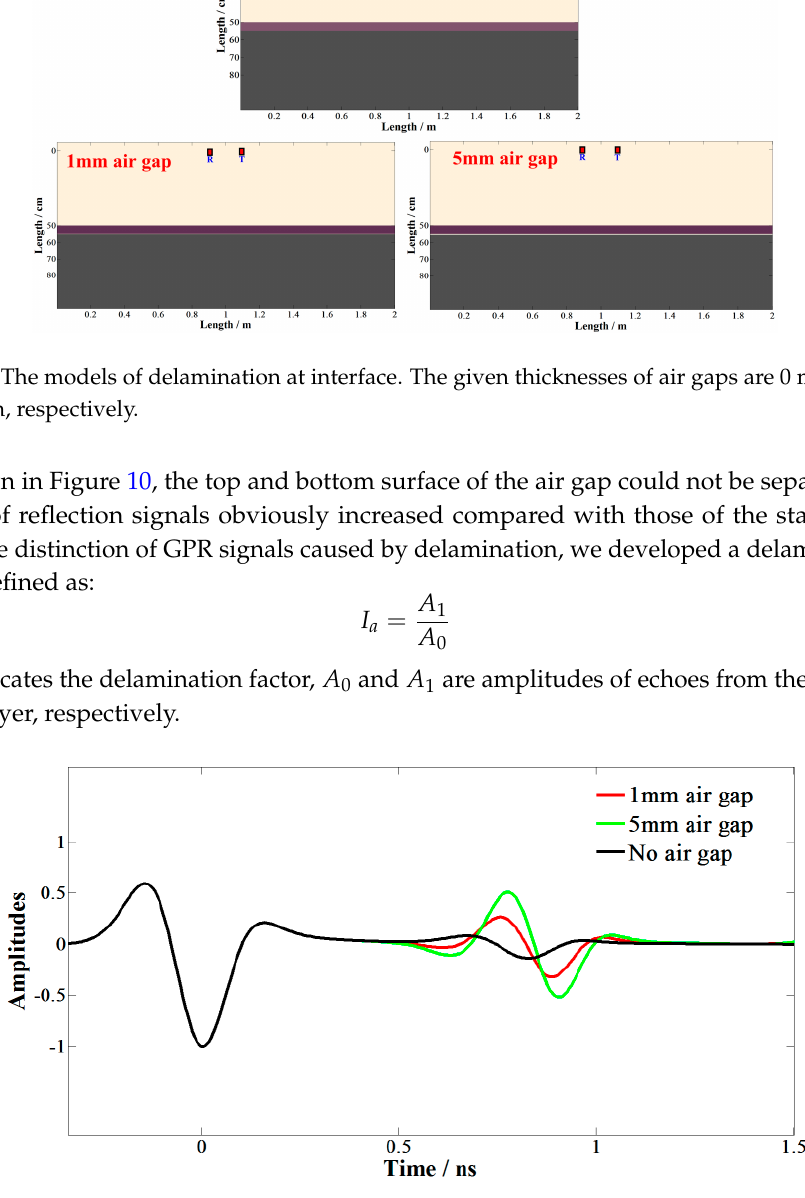
Figure 10. The simulated GPR signals of the three models in Figure 9.